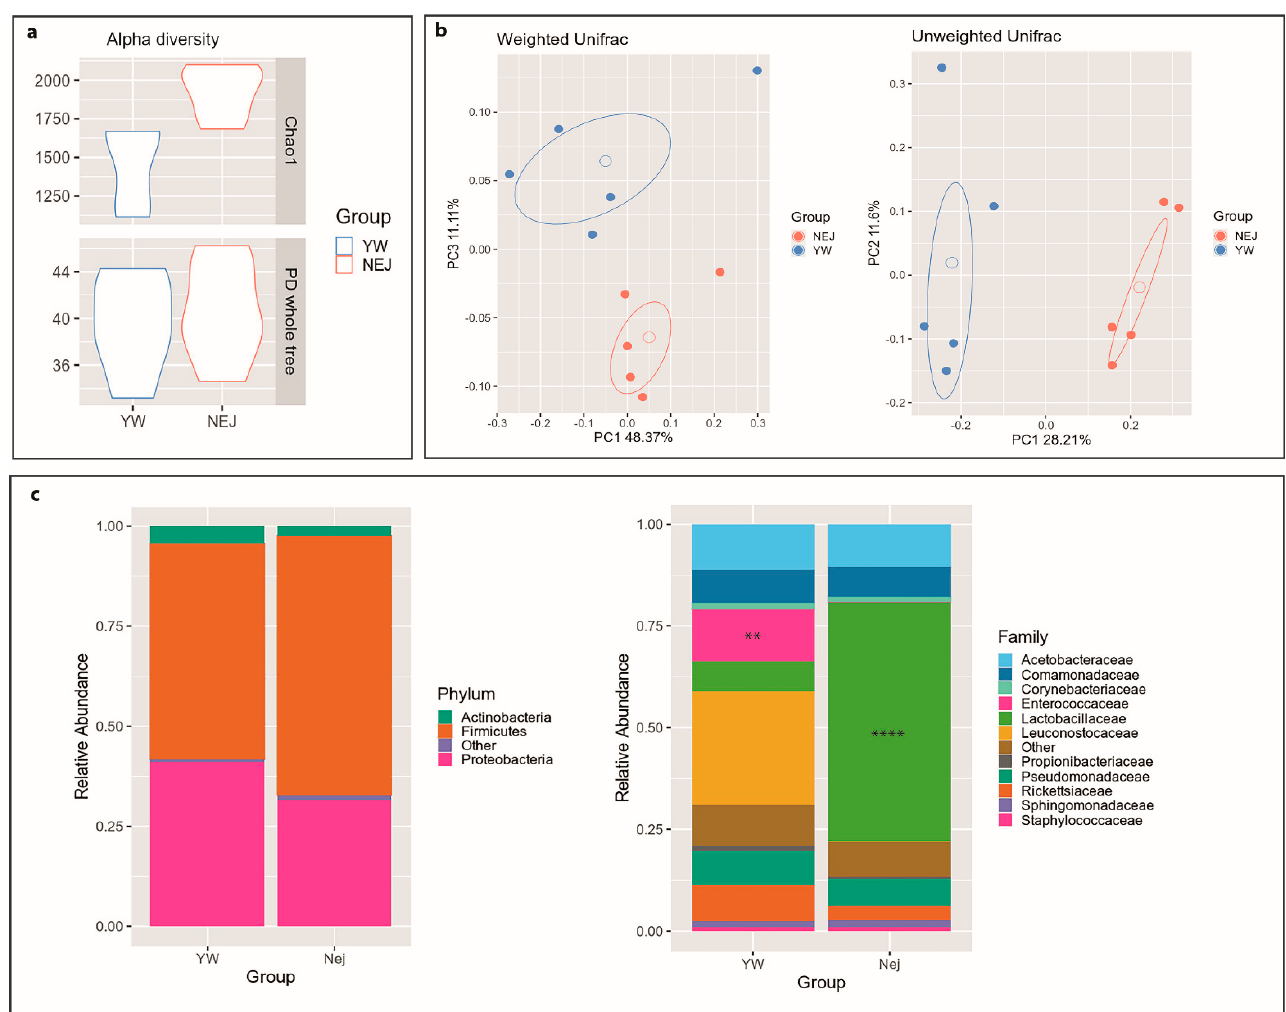
Figure 4. Drosophila gut microbiota analysis. Gut microbial communities were characterized by 16S rRNA gene sequencing. ( a ) Alpha diversity. Violin plots show biodiversity values for Chao1 ( p = 0.005) and Faith’s phylogenetic metrics (PD whole tree; p = 0.668). ( b ) Principal coordinate analysis (PCoA) for both Unifrac distances. ( Adonis test: weighted p = 0.216; unweighted p = 0.007). ( c ) Relative taxonomic abundances of the gut bacterial composition in yw and nej flies at phylum and family levels. All bacterial taxa present at <1% relative abundance were grouped into the “Other” classification. ****: p < 0.001; **: p < 0.01.